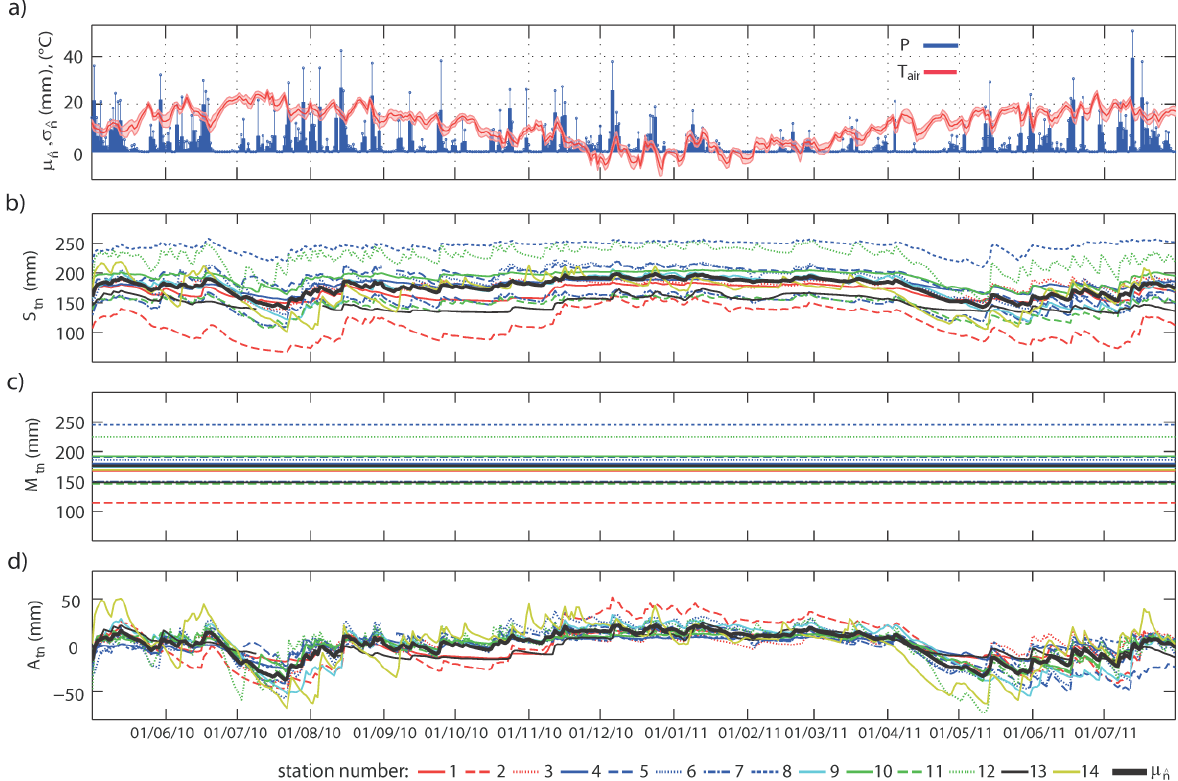
Fig. 3. Time series of spatial mean and spatial standard deviation (stem and shaded areas) for (a) precipitation P and 2-m air temperature T air . Time series of each site as well as the spatial mean (black bold lines) of (b) absolute soil moisture S tn and its decomposed (c) time-invariant (temporal mean) M tn and (d) time-varying (anomalies) A tn